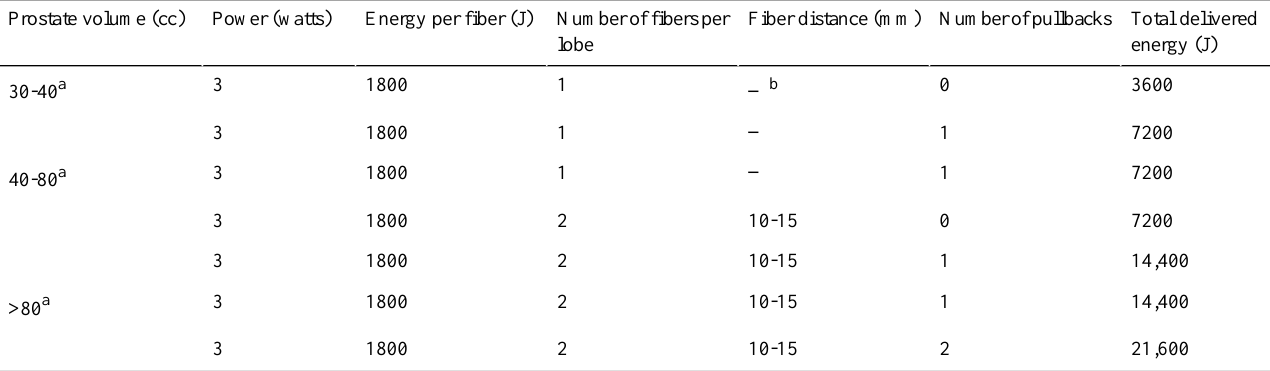
Table 1. Overview of the number of fibers used and fiber distance based on prostate volume (based on the manufacturer’s instructions).